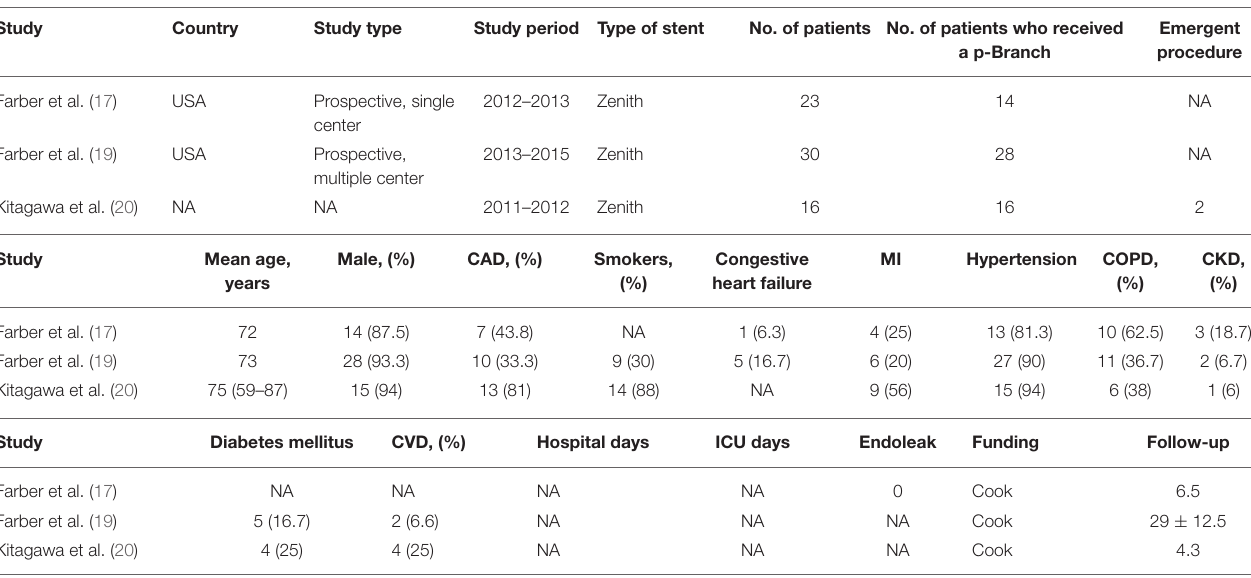
TABLE 3 | Baseline characteristics of studies funded by